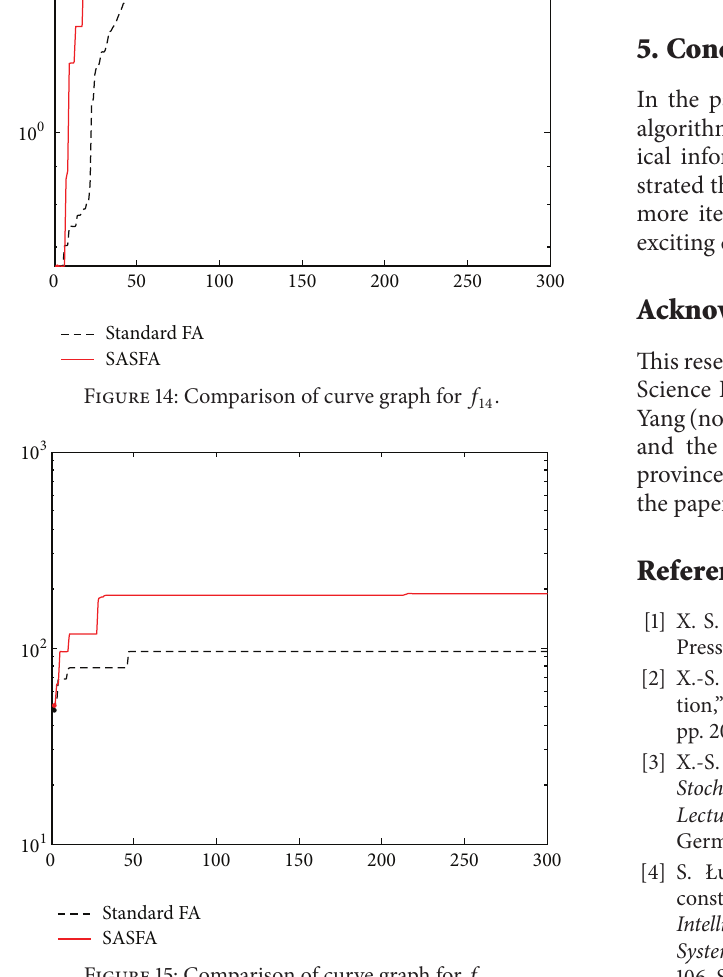
Figure 15: Comparison of curve graph for 𝑓 15 .